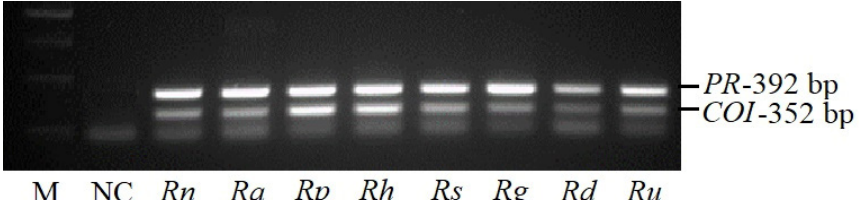
Table 1. Selected primer pairs with degenerate nucleotides for PR and COI detection. Figure 2. Amplified PCR fragments obtained with primer pairs PRPd and COId in Ribes